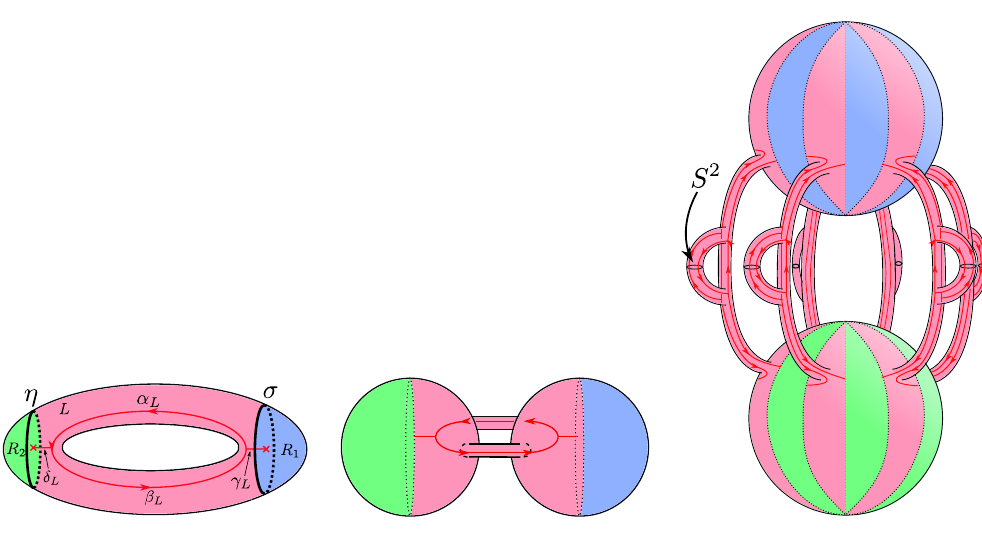
Figure 13 . (Left) The state on the torus and (middle) the same state redrawn suggestively. (Right) The three-manifold of the replica path